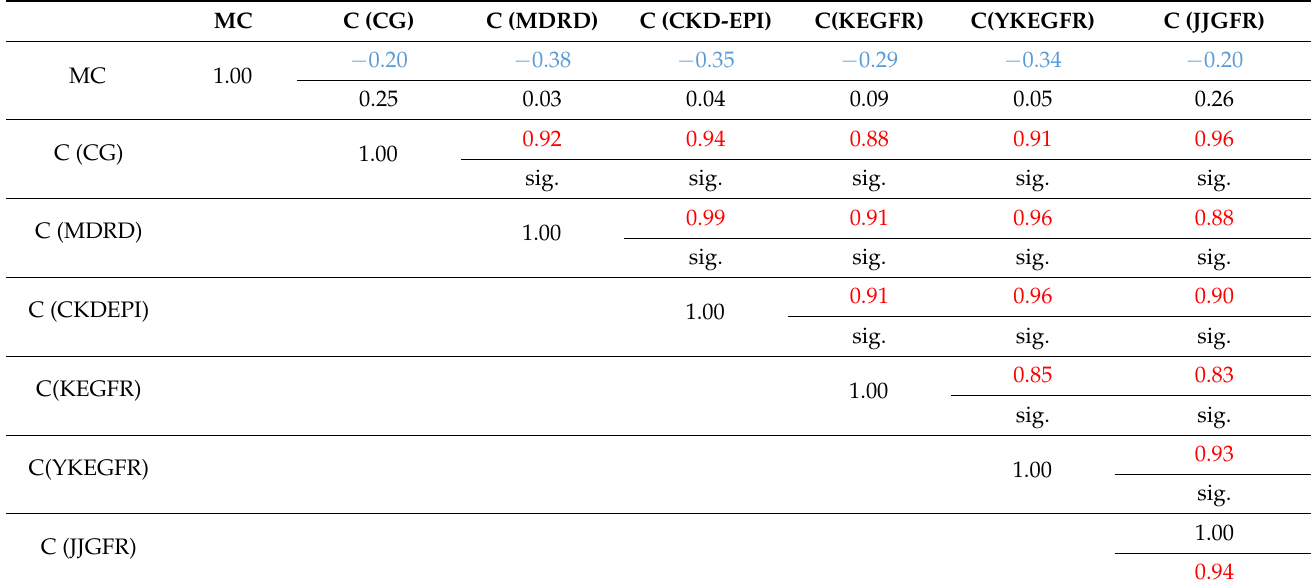
Table 3. Correlation of the predicted (C) and measured concentrations (MC) with different methods to estimate kidney function with individual PK models with the single-dose intermittent infusion (SDII) equation (Spearman correlation coefficients with representative p values, N = 34), sig. = p < 0.0001. Red color indicates positive correlation; blue color indicates negative